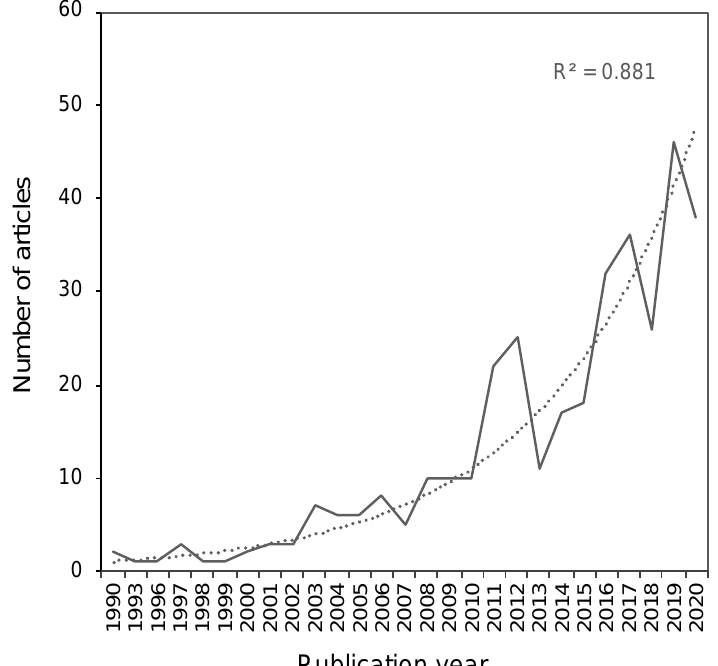
Figure 3. The number of articles returned from our search of the literature for evidence of sentience in fish. The graph shows the exponential growth trend (R 2 = 0.881) in the number of research articles published each year between 1990 and 2020 that utilized one or more species of fish in an experimental study of sentience.